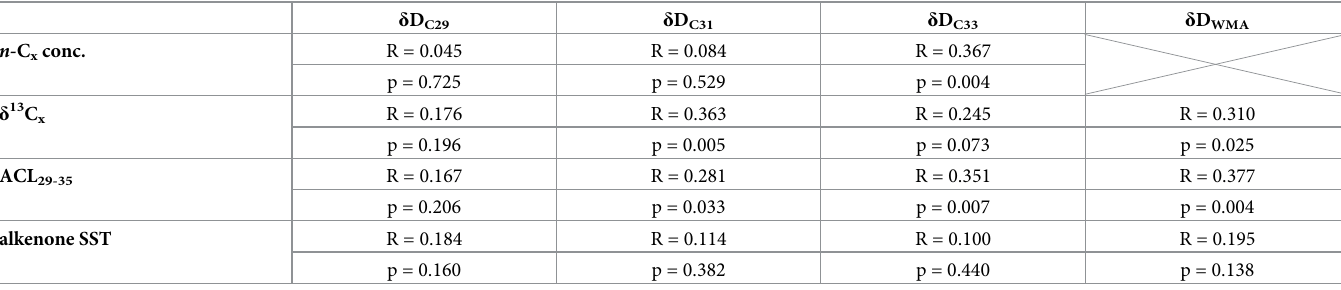
Table 3. Correlation of paleoclimatological parameters from